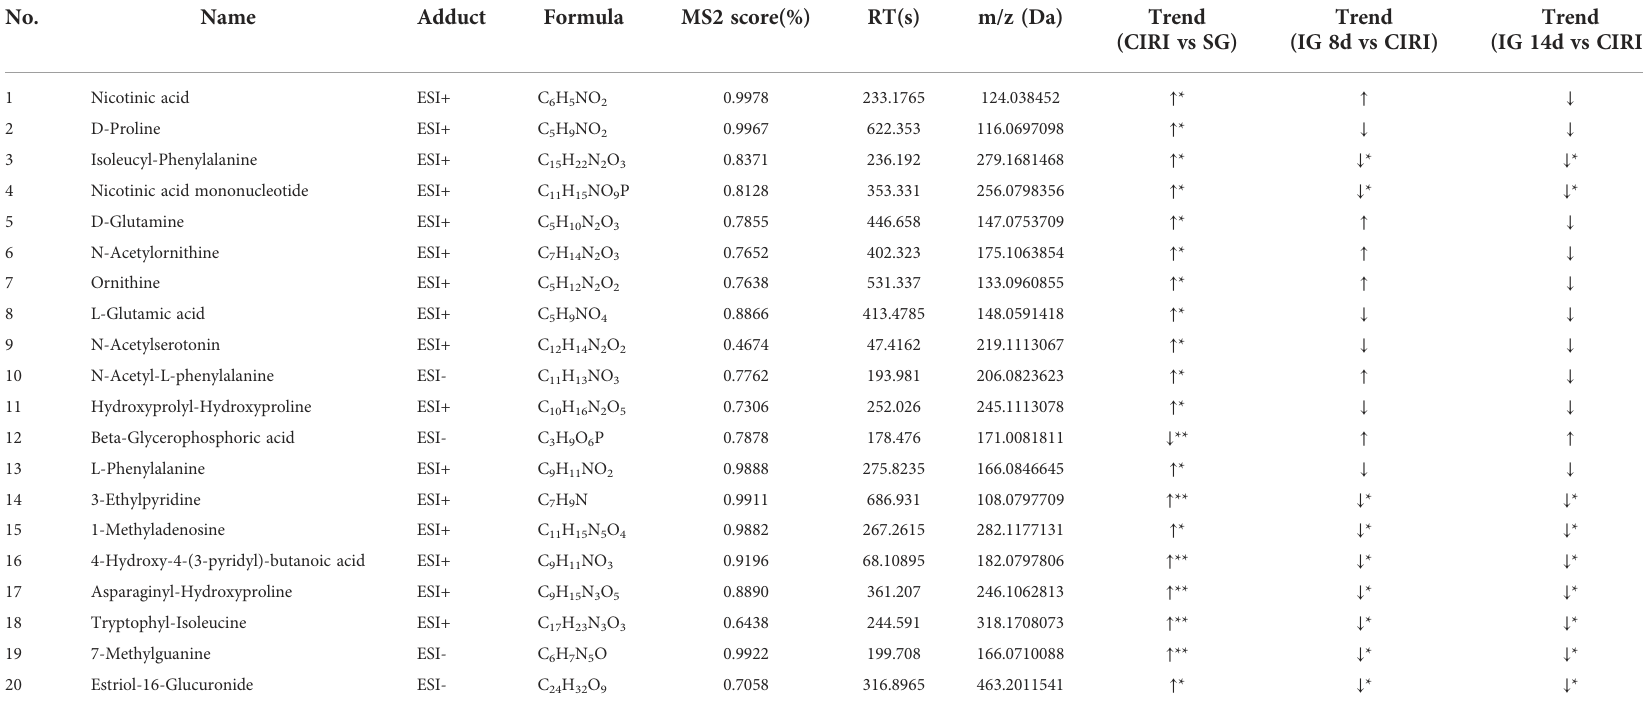
TABLE 3 Results of potential biomarkers detected in rat cecal